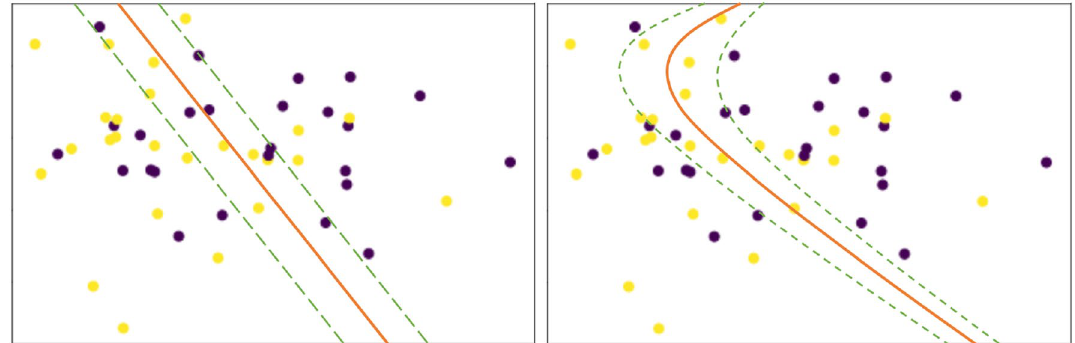
Figure 4. SVM classification results based on linear kernel and polynomial kernel functions.